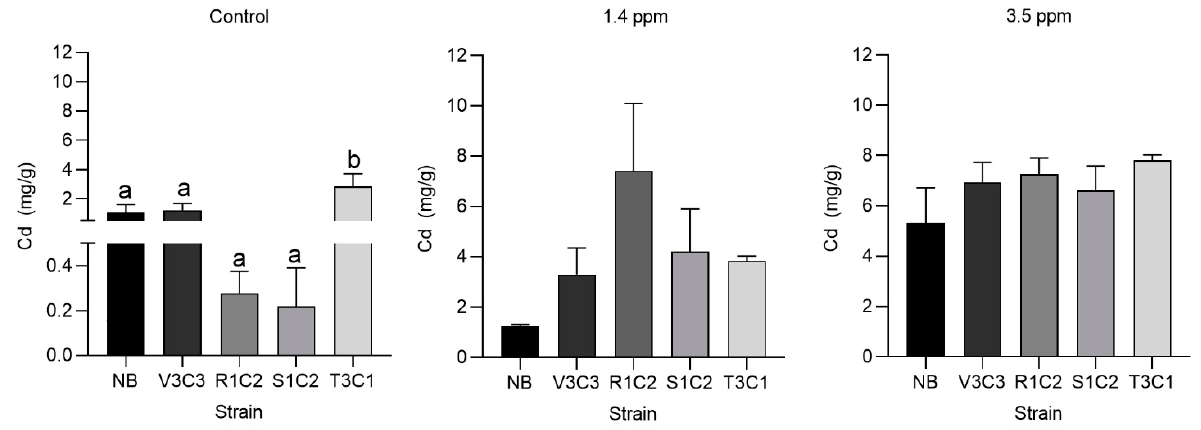
Figure 5. Effect of selected hypertolerant bacteria in stem cadmium accumulation by Theobroma cacao . Bars are means of three to five biological replicates ± SE. The values were analyzed by ANOVA followed by Tukey’s multiple-comparison test. Different letters indicate statistically significant differences ( p ≤ 0.05). The graphics were performed using GraphPad software v.8.0.1. by Dotmatics, San Diego, CA, USA.